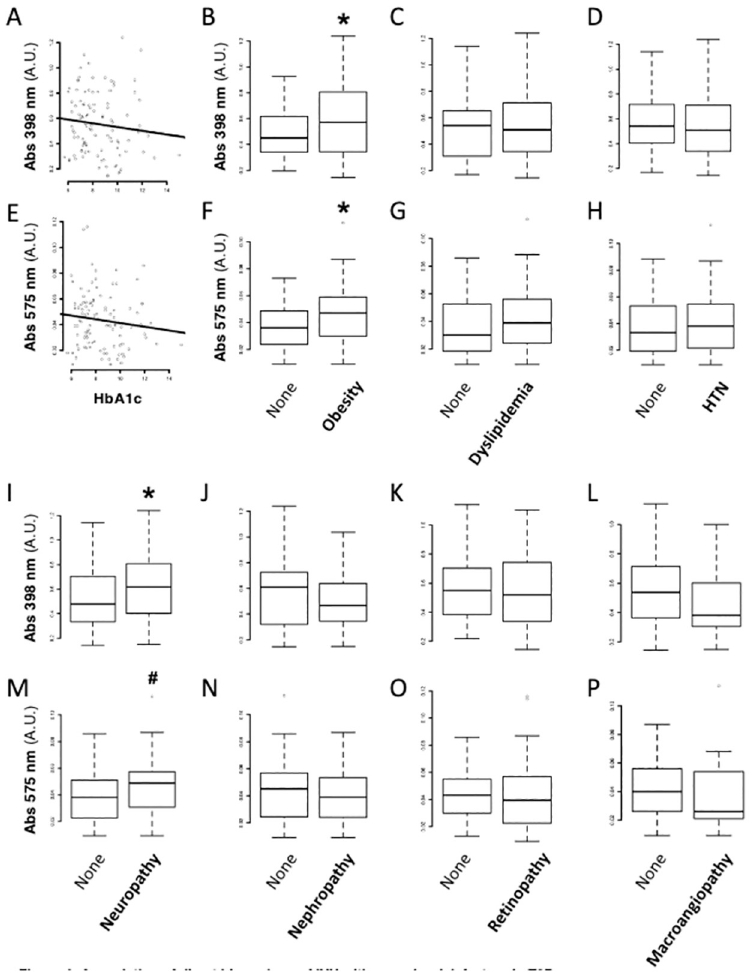
Fig 4. Association of direct biomarkers of IVH with vascular risk factors in type 2 diabetes. We crossed our direct IVH biomarkers with clinical data. We investigated the association of plasma absorbance at 398 nm (A-D , I-L) and 575 nm (E-H , M-P) with subgroups of patients with T2D. First, we assessed the correlation of Abs398 and Abs575 with glycated hemoglobin (Hb1Ac) levels (r = -0.12 and -0.11, respectively. p > 0.2 for both). Next, we assessed their association with obesity, dyslipidemia and hypertension (HTN) (A-H) . Abs398 and Abs575 were significantly increased in obese vs. non-obese patients with T2D. Finally, we assessed their association with peripheral neuropathy, nephropathy, retinopathy or macroangiopathy (I-P) . ( � ) p < 0.05 vs. Controls (#) p = 0.051 vs Controls. (see Table 2 for adjusted logistic regressions using Log-transformed absorbances).